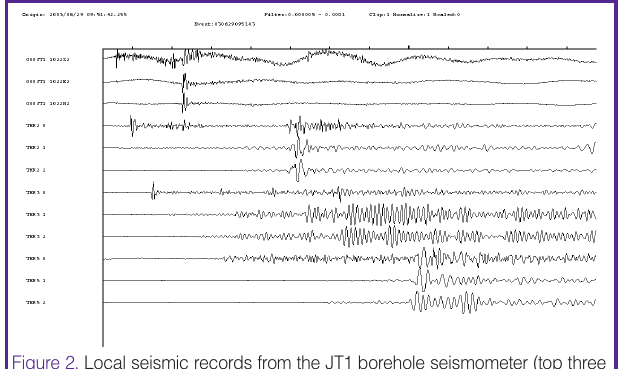
Figure 2. Local seismic records from the JT1 borehole seismometer (top three traces for vertical and horizontal components) and those from OBS around the JT1 borehole observatories (three stations [THK] each with three components).